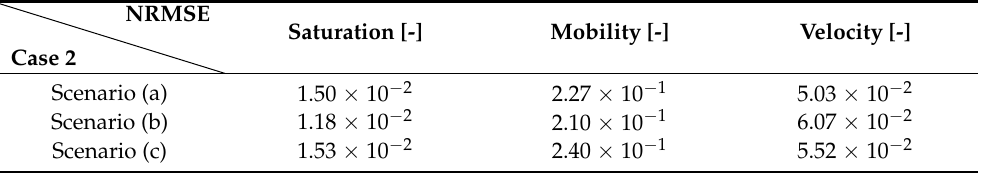
Table 8. NRMSE values for the mobile (liquid) phase parameters between Darcy and Forchheimer– Case 2 models (t =